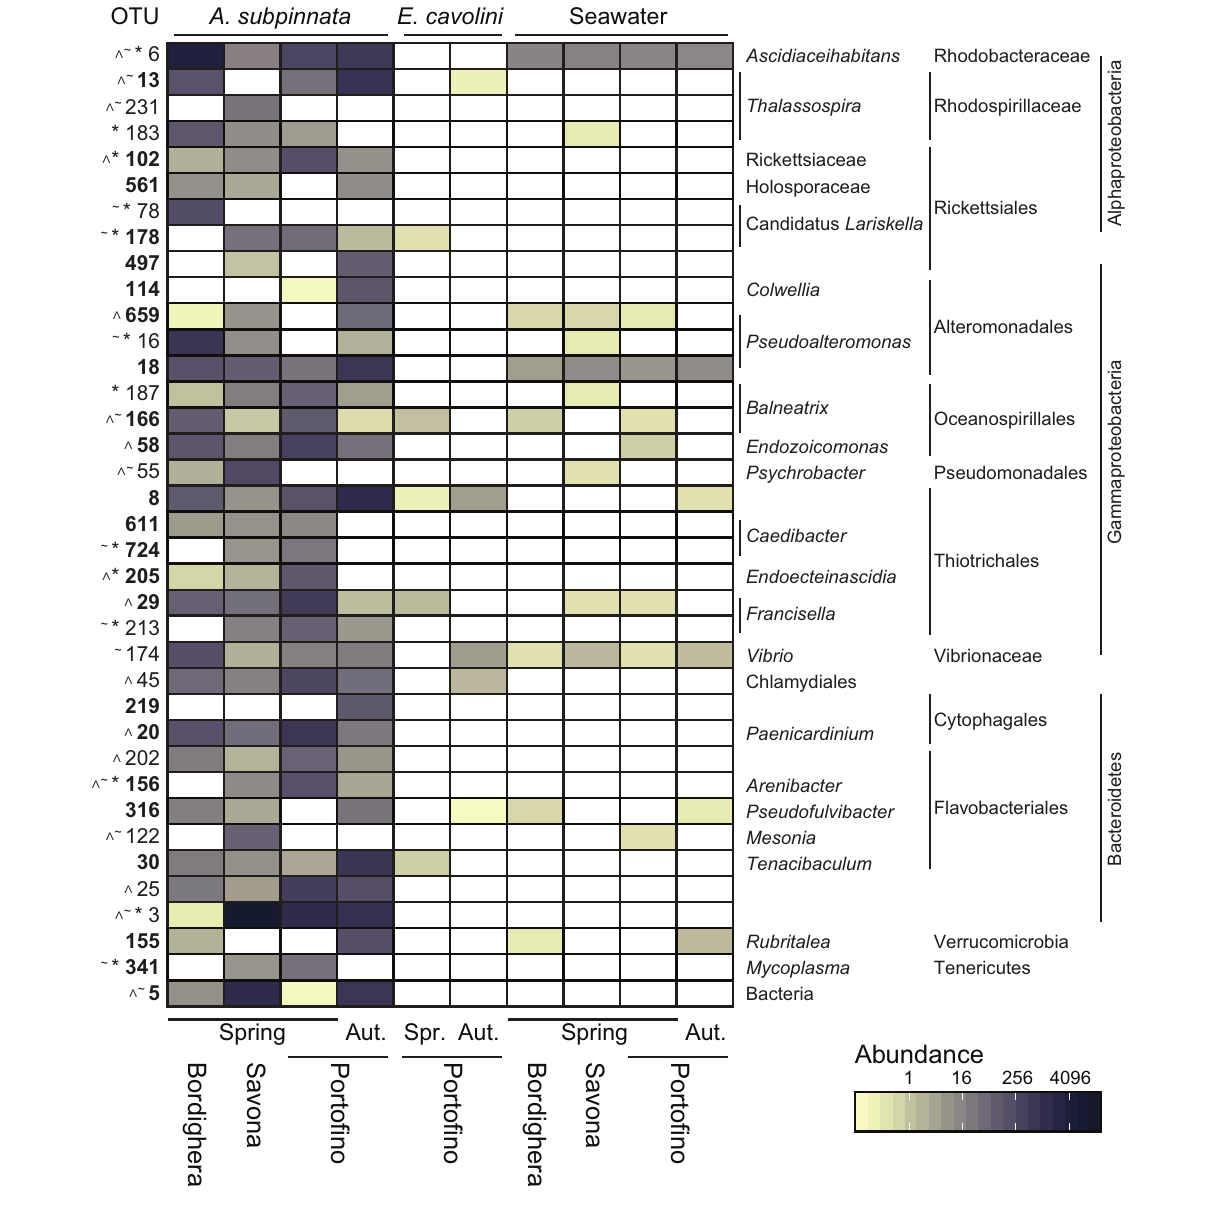
FIGURE 6 | Microbes associated with Antipathella subpinnata that show differential abundance between locations or time points. Heatmap presents the abundance of OTUs found differentially abundant between locations (Bordighera, Savona and Portofino) in the spring (Spr., April/May 2017) and/or between spring and autumn (Aut., November 2016) at the Portofino location. Abundance of these OTUs in the microbiota of E. cavolini and seawater is also provided. The taxonomy of each OTU is given at the lowest possible taxonomic level. Symbols indicate OTUs showing spatial differences ( ∼ Bordighera versus Savona, * Bordighera versus Portofino, ˆ Savona versus Portofino). OTUs in bold were found differentially abundant between time points. OTUs presented have a higher relative abundance in A. subpinnata than seawater. See Supplementary Figure S4 for OTUs with equal or lower relative abundance in A. subpinnata than